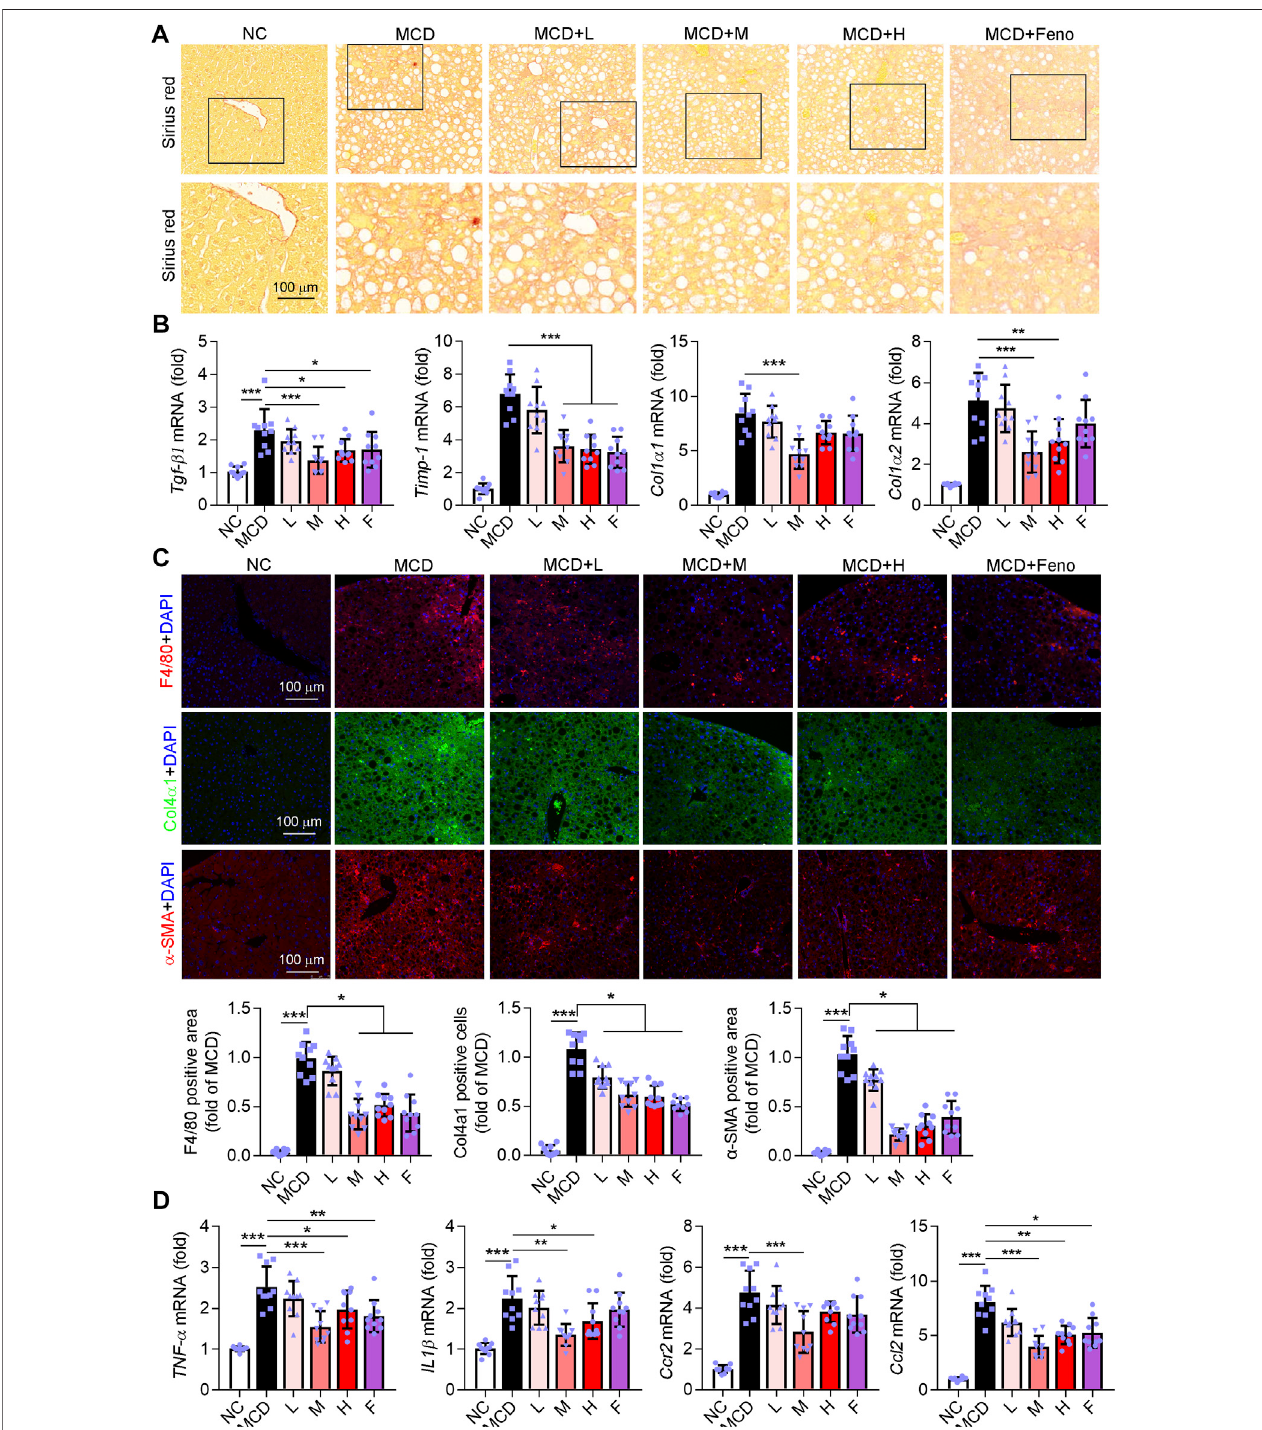
FIGURE 5 | Ganweikang tablet ameliorates fi brosis and in fl ammation in the liver of MCD-fed NASH mice. (A) Representative images of Sirius Red staining, n = 10. (B) q-RT-PCR analysis of the mRNA level of TNF α , IL1 β , Ccr2 , and Ccl2 in the liver, n = 10. (C) Mouse liver sections were stained for F4/80, Col4 α 1, and α -SMA, respectively,andfollowedbyquantitativeanalysis, n =10.F4/80(red),Col4 α 1(green), α -SMA(red),andDAPI(blue). (D) q-RT-PCRanalysisofthemRNAlevelofTgf- β 1, Timp-1, Col1 α 1, and Col1 α 2 in the liver, n = 10. * p < 0.05, ** p < 0.01, *** p < 0.001, by one-way ANOVA with Bonferroni correction.